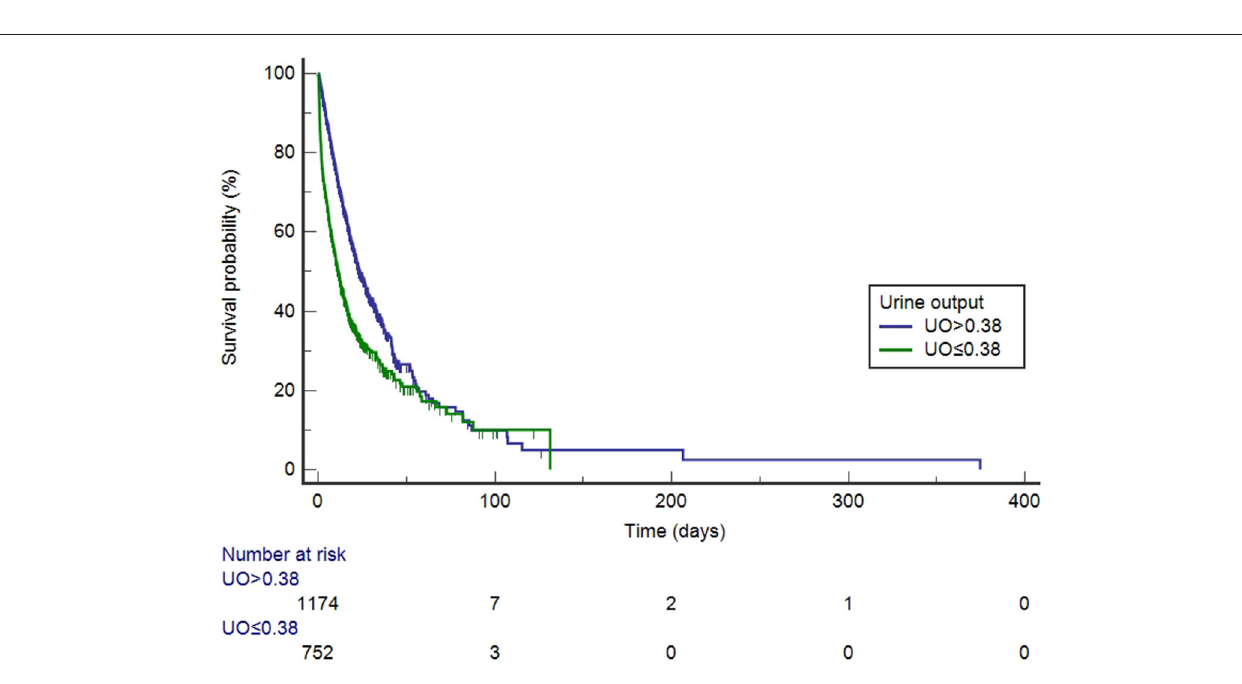
therapy, but is directly related to the prognosis of the patients, reflecting the independence of its predictive